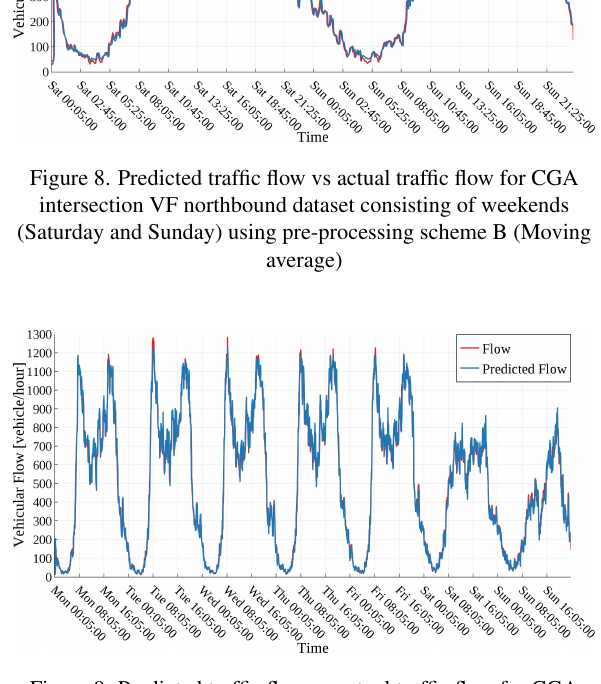
Figure 9. Predicted traffic flow vs actual traffic flow for CGA intersection VF northbound dataset consisting of an entire week using pre-processing scheme C (Moving average without timestamp